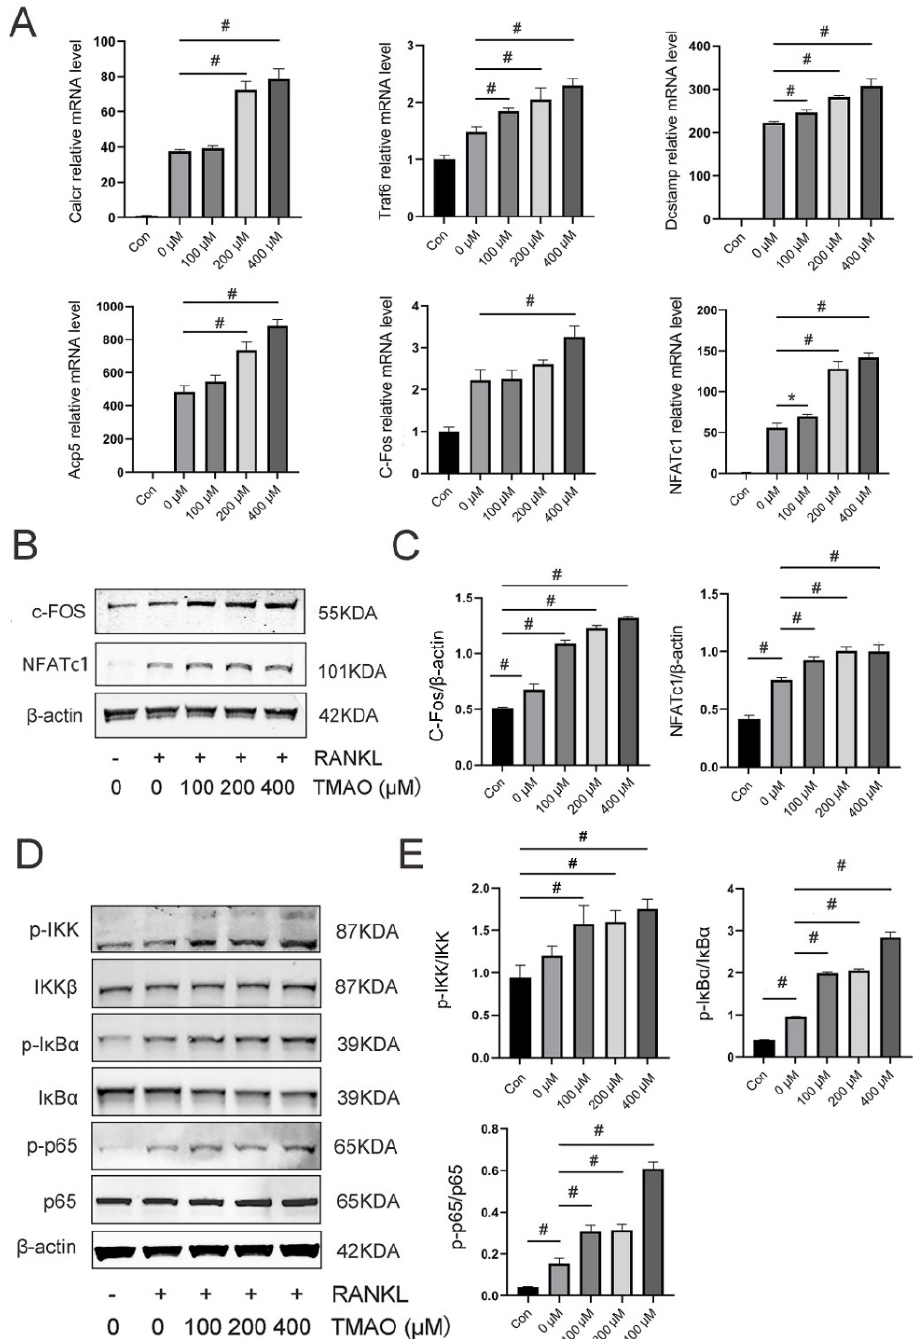
Figure 3. TMAO enhanced osteoclast gene expression and the NF- κ B signaling pathway. ( A ) TMAO enhanced osteoclast gene expression ( n = 3 per group) as examined by real-time PCR. ( B , C ) TMAO enhanced c-Fos and NFATc1 protein expression as evaluated by Western blot ( n = 3 per group). ( D , E ) The protein expression levels of p -IKK, IKK, p-I κ B α , I κ B α , p-p65, and p65 were examined by Western blot after TMAO treatment. TMAO increased RANKL-stimulated phosphorylation of IKK, I κ B α , and p65 ( n = 3 per group). * p < 0.05, # p <